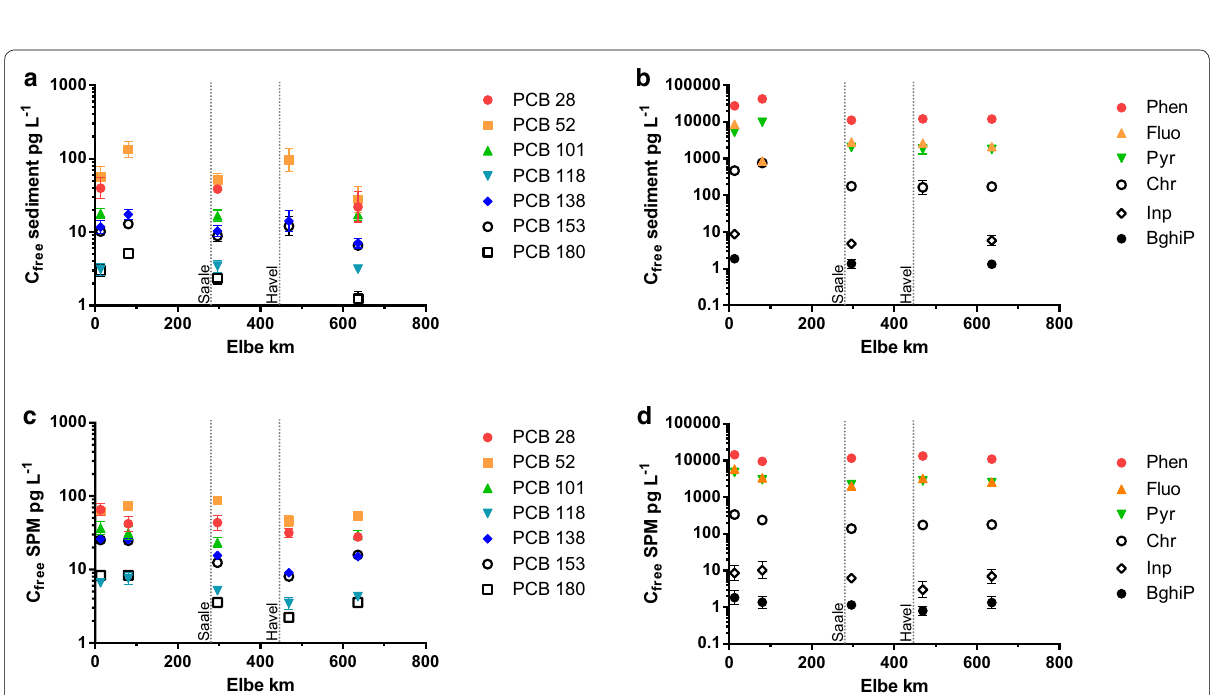
Fig. 3 C free (pg L − 1 ) of PCBs ( a , c ) and selected PAHs ( b , d ) in sediment and SPM samples along the German part of the River Elbe. Data points are mean values and the error bars represent the standard deviations.